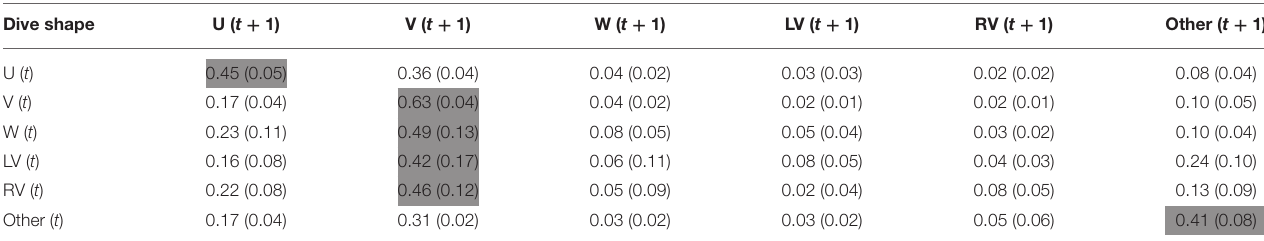
TABLE 2 | Transition matrix averaged for the six basking sharks. Dive